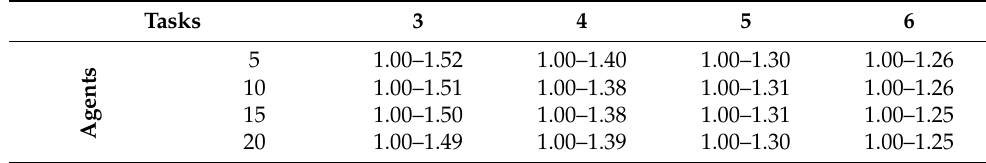
Table 5. Range of Reliability Improvement Factor (Scenario 1).